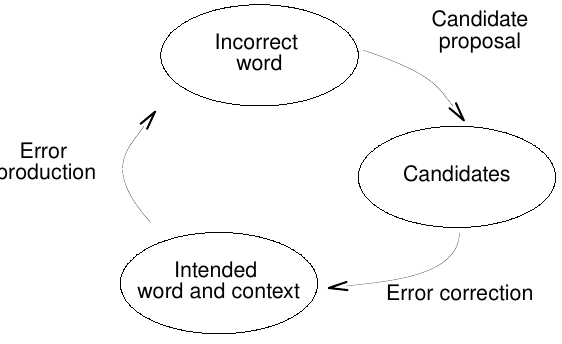
Figure 1. Interactive processes of error production and